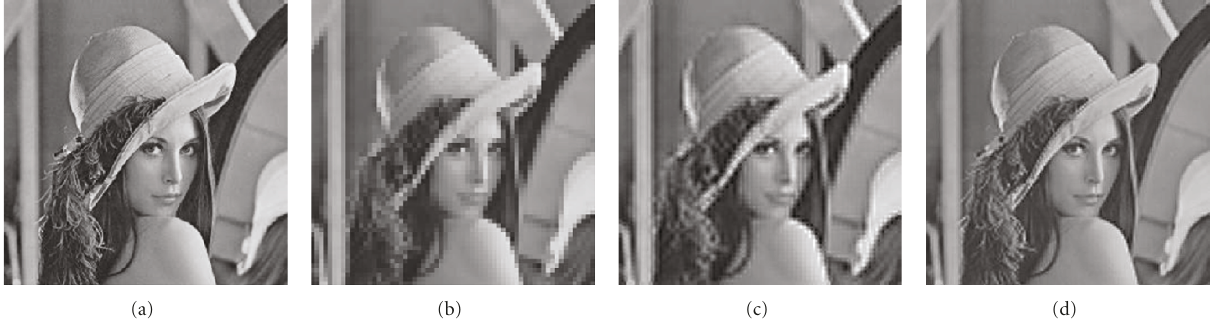
Figure 5: (a) Original Lena, (b) Lena created using only DC coe ffi cients of original image, (c) Lena created using estimate formulas (Gonzales method [3]) on image (b), and (d) Lena created using estimate formulas (Veeraswamy method [4]) on image (b).